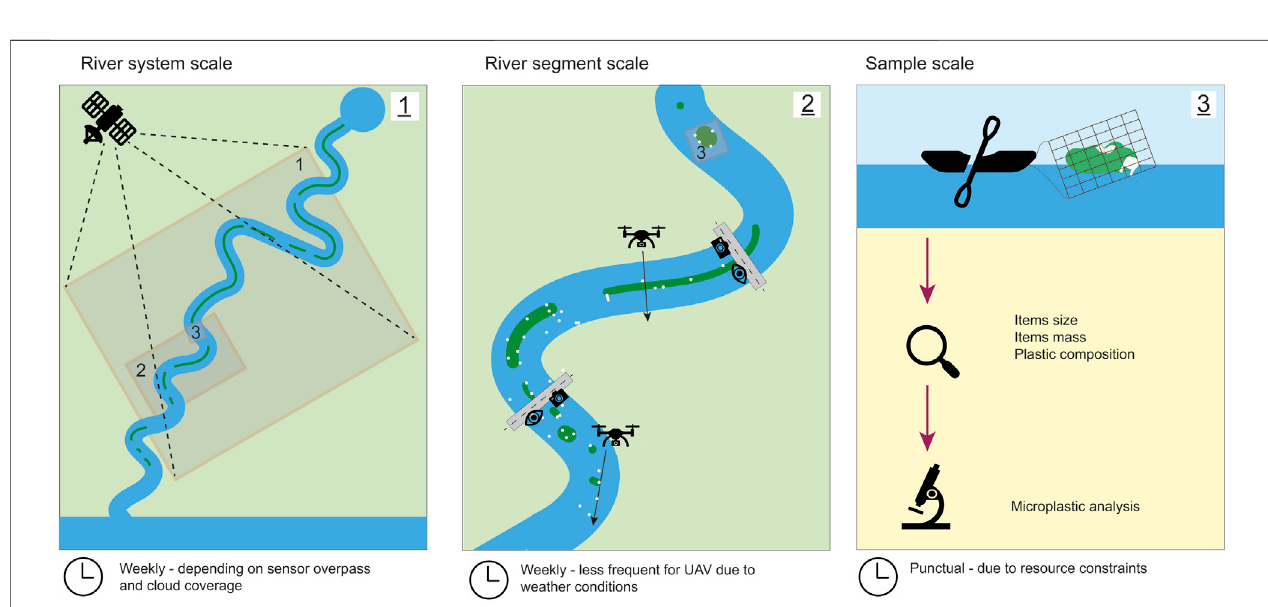
FIGURE 12 | Schematic overview of the various spatial scales and temporal frequency at which the measurements can be done.